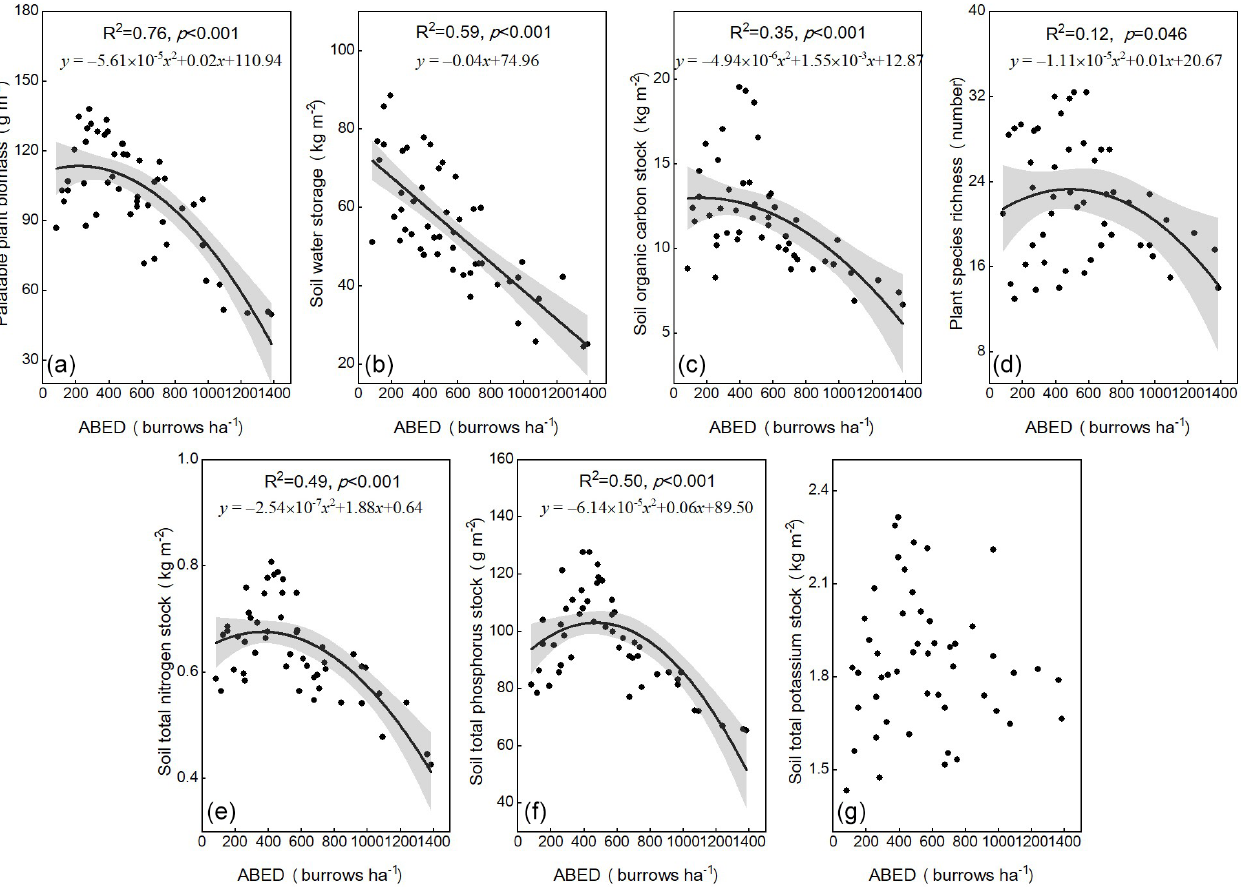
Figure 2. The palatable plant biomass ( F = 69) (a) , soil-water storage ( F = 69) (b) , soil organic carbon stock ( F = 13) (c) , plant-species richness ( F = 3.3) (d) , soil total nitrogen stock ( F = 23) (e) , soil total phosphorus stock ( F = 24) (f) and soil total potassium stock (g) for different disturbance intensity of plateau pikas based on linear models (LMs). An adjusted local smoothed regression line (black) with its 95% confident interval (gray) was used to determine the relationship between the disturbance intensity of plateau pikas and the indicators above. ABED: active burrow entrance